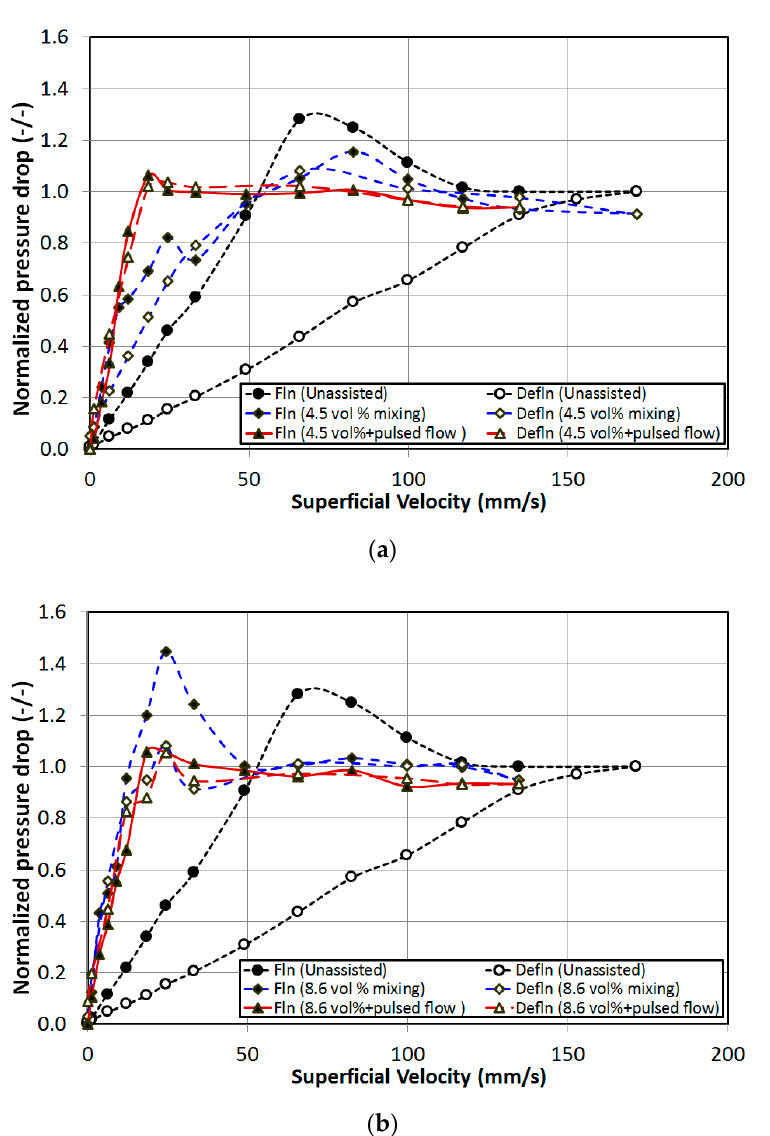
Figure 3. Effect of velocity and particle mixing on the pressure drop behavior of the fluidized bed.